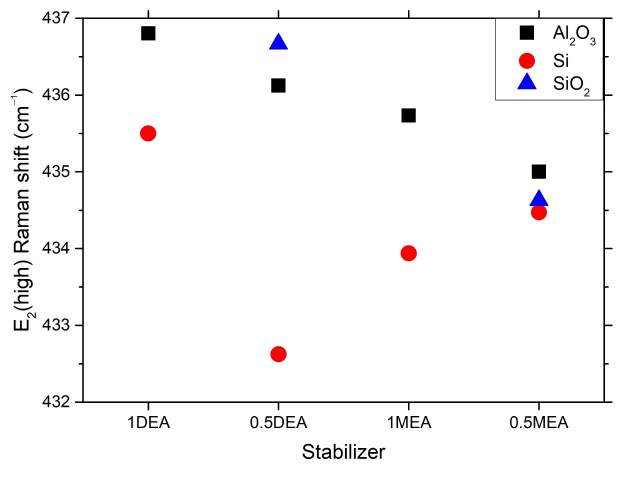
Figure 12. ZnO E 2 (high) mode Raman shift in regard to substrate, stabilizer, and its concentration. As may be observed, the E 2 (high) mode has a higher Raman shift value for